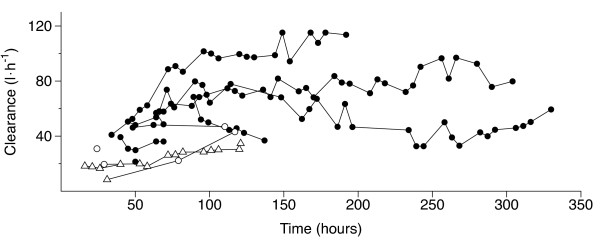
Dexmedetomidine clearance at 116 steady states defined by a 15-hour constant-rate infusion in 12 subjects. Open triangles, open circles, and solid circles indicate an infusion rate of 0.1, 0.4 to 2.1, and 2.5 μg/kg/h, respectively. Each line represents one patient. In two patients, only one steady state was achieved, and the corresponding clearances are depicted with a single symbol.